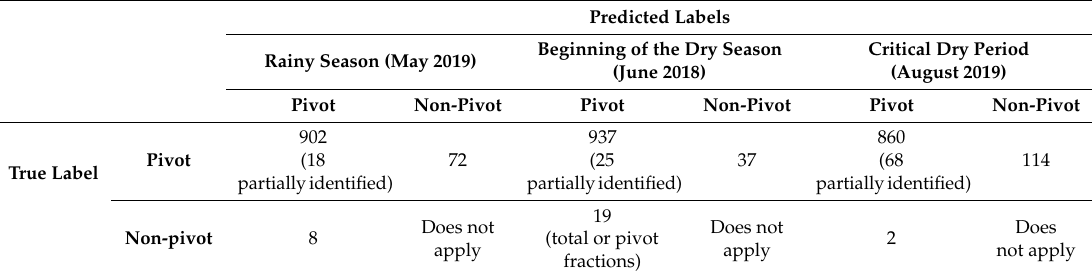
Table 5. Confusion matrix containing the number correctly and incorrectly classified targets from the reconstructed image of the three periods using a stride of